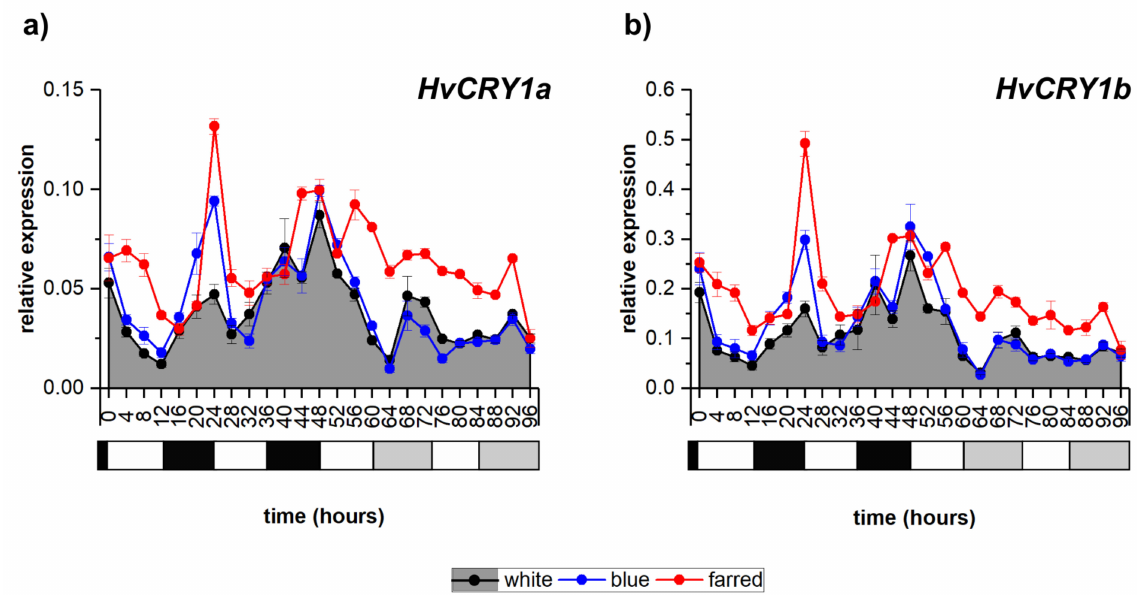
Figure 1. Expression patterns of barley cryptochrome-coding genes HvCRY1a ( a ) and HvCRY1b ( b ) under white, blue and far-red illumination. Values on the X axes show the time in hours after the start of the experiment; white and black bars below them indicate the light and dark periods, while gray bars indicate the subjective “night” period during constant-light conditions. Transcript levels were calculated with ∆ Ct method, with expression data and error bars indicating standard deviations were calculated using three biological replicates. The following significant differences were calculated at p ≤ 5% level: HvCRY1a —0.015; HvCRY1b